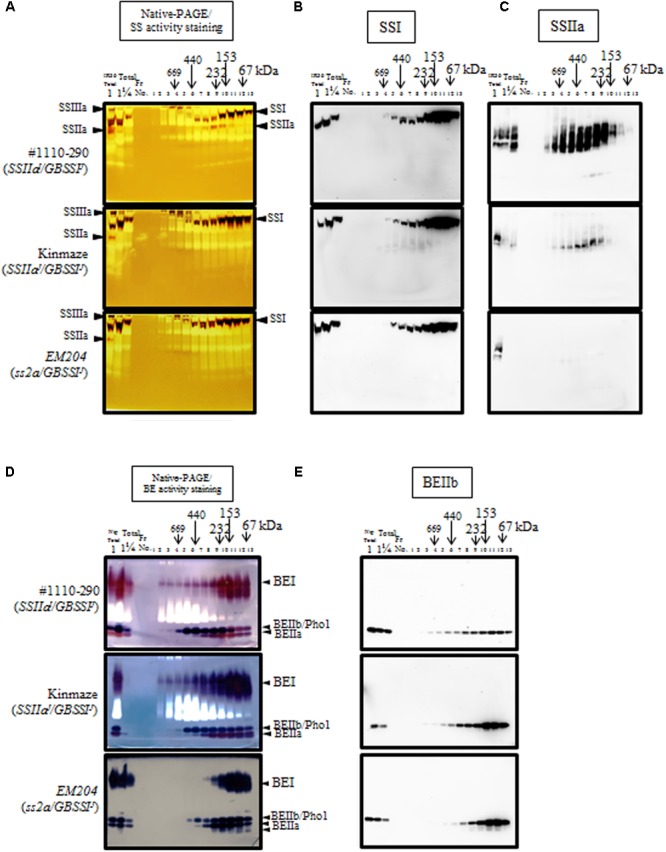
Molecular weight distribution of starch synthase (SS) (A–C) and branching enzyme (BE) (D,E) analyzed by native-PAGE/activity staining (A,D) and immunoblotting of the corresponding gel (B,C,E) loaded with the fractions obtained from gel filtration chromatography of soluble extract from rice developing endosperm. #1110-290, SSIIaI/GBSSIJ; Kinmaze and Nipponbare, japonica rice cultivar, SSIIaJ/GBSSIJ; EM204, ss2a/GBSSIJ. The left lane of each native-PAGE/activity staining gel and immunoblot is the loading control (IR36 for SS and Nipponbare for BE), except for D and E in Kinmaze, which are blanks. Total is the crude extract before gel filtration chromatography loaded with different amounts of extract (1 and ¼) for semi-quantitative comparisons. More mobile purple bands in EM204 of BE activity staining (D) are also BEIIa.